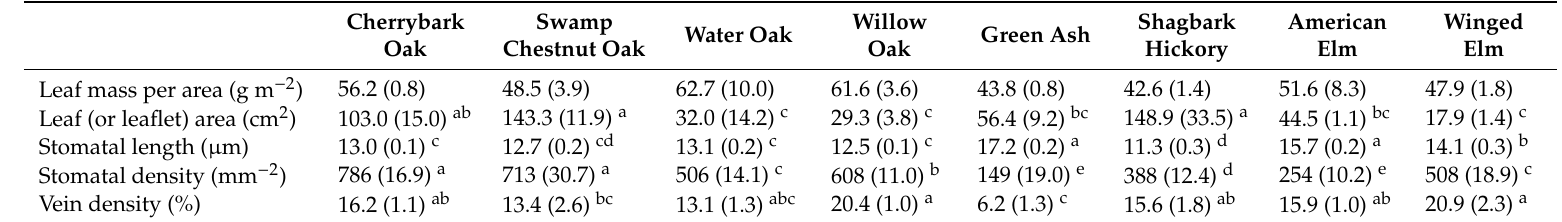
Table 2. Mean (standard error in parentheses) leaf anatomical parameters for bottomland hardwood study species.